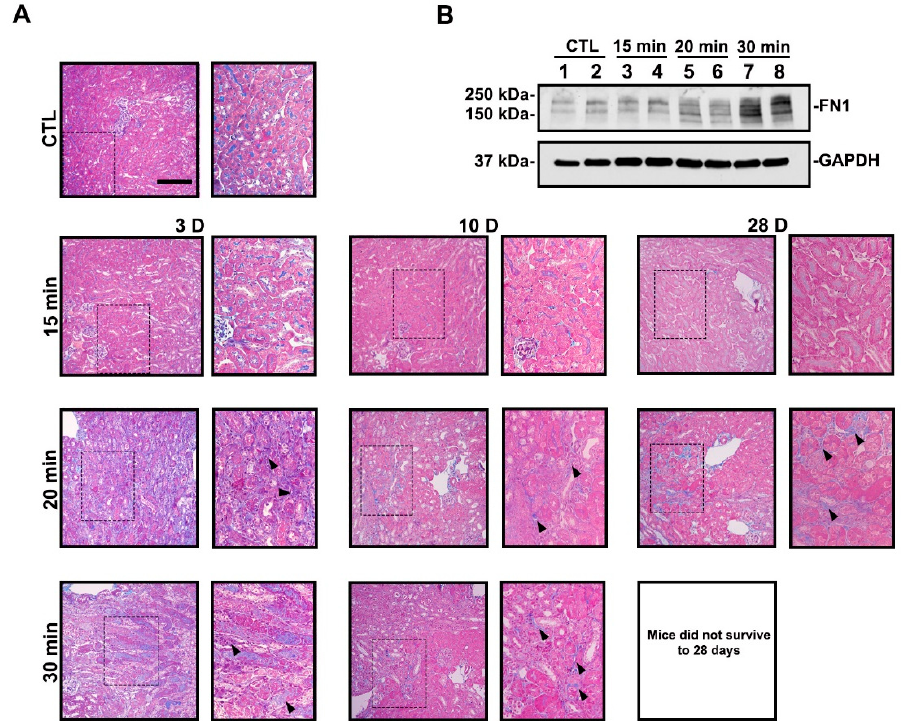
Figure 2. Longer ischemia times promote renal fibrosis. ( A ) Representative MTS images are shown. Thirty-minute ischemia leads to animal death by day 28. Kidney sections from the 30-min group display extensive collagen deposition (blue staining, arrowheads). Contralateral kidney from day 3 is used as the control. Bar = 100 µm. Enlargement of the boxed area is shown to the right of each image. ( B ) Immunoblot of FN1 protein expression at day 10. FN1 expression increased with longer ischemia times.